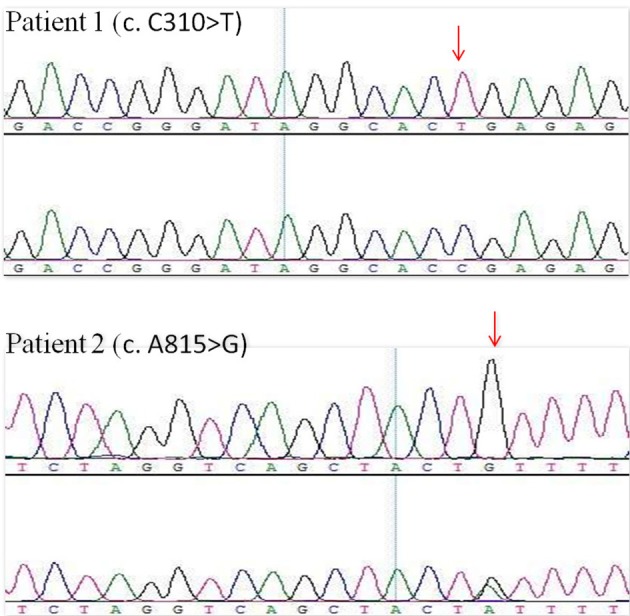
CLCN5 NGS verification analysis. A hemizygotic mutation (c. C310T,p.R104X) was found in the patient 1. Another hemizygotic mutation (c. A815G,p.Y272C) was found in the patient 2.